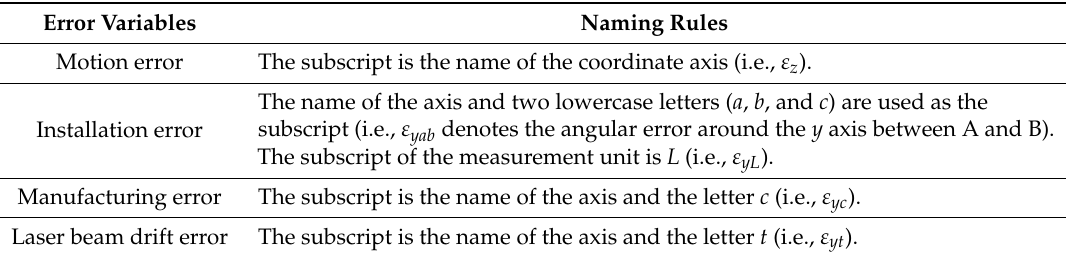
Table 1. Error variables and the naming